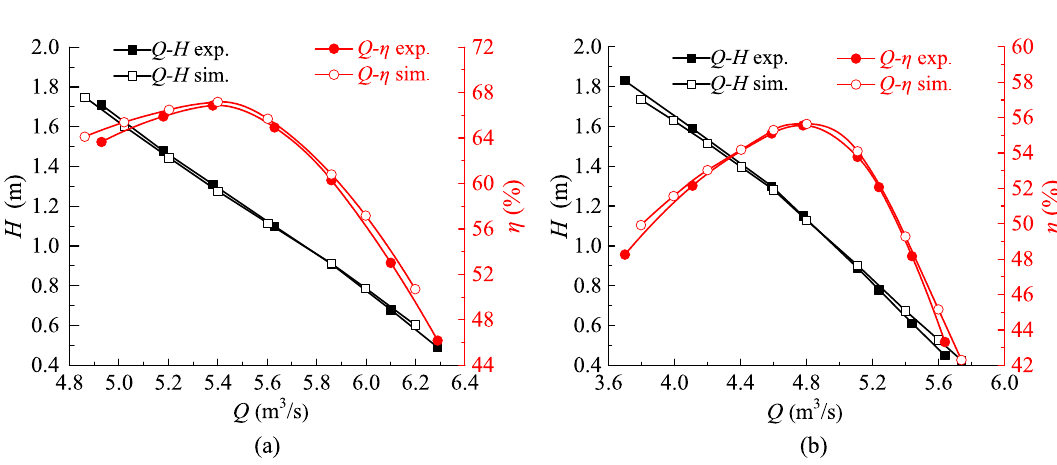
Figure 6. Numerical simulation and test data comparison in terms of pump head and efficiency, ( a ) FRC, ( b )